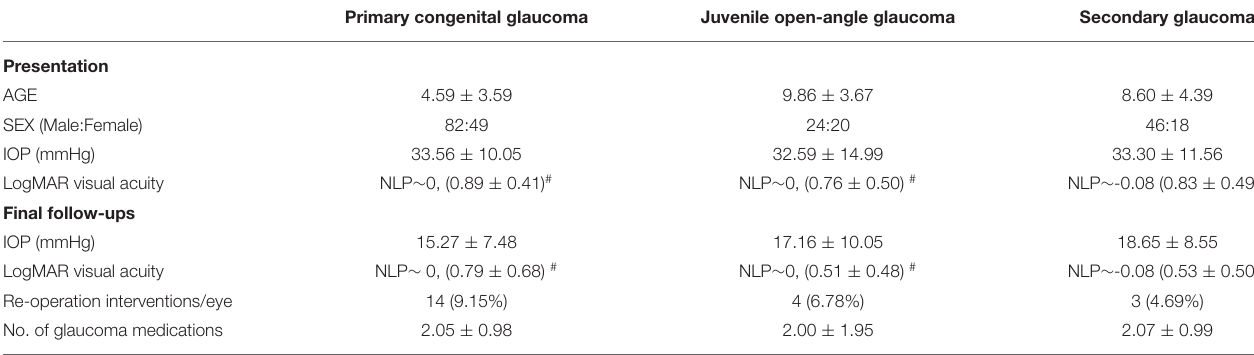
TABLE 5 | Final clinical outcomes among different types of pediatric glaucoma *